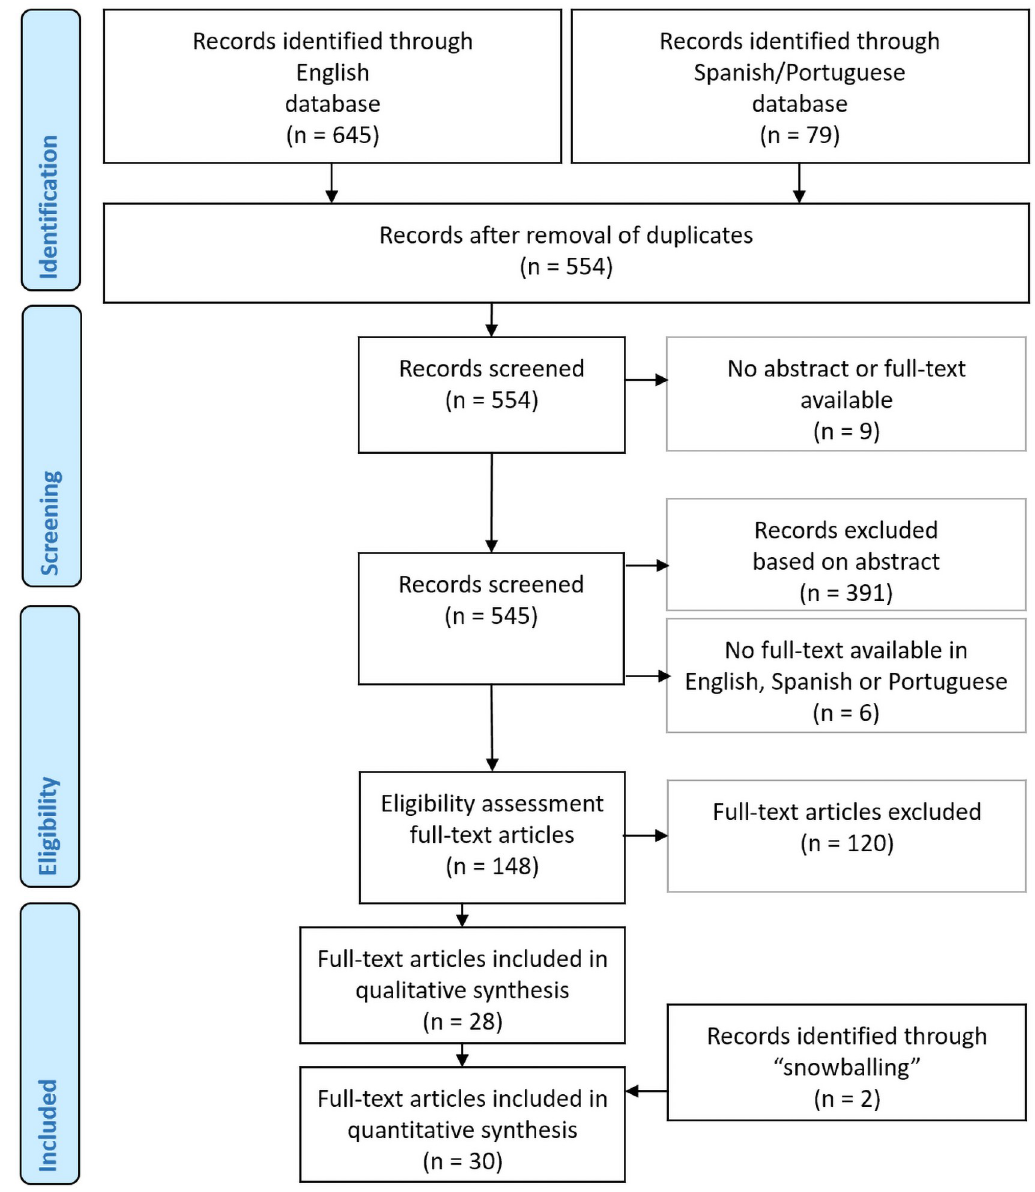
Fig 1. PRISMA flow chart. Overview of the selection procedure of 30 full-text articles included in the